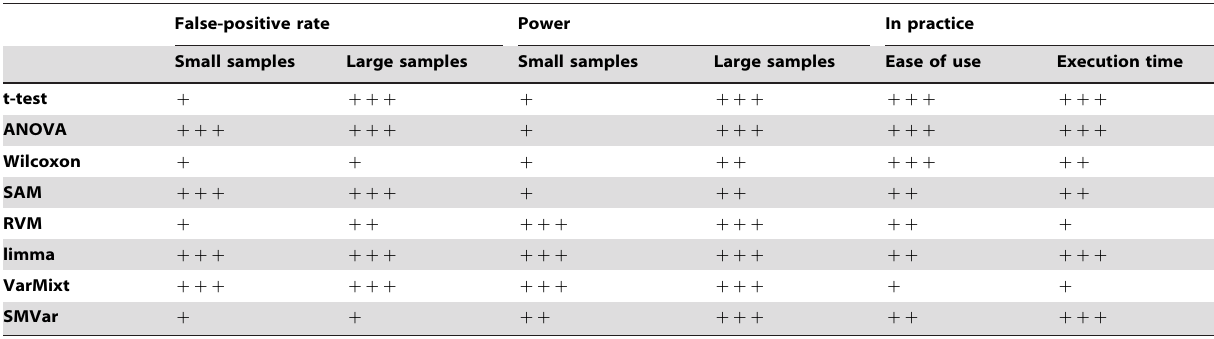
Table 3. Summary